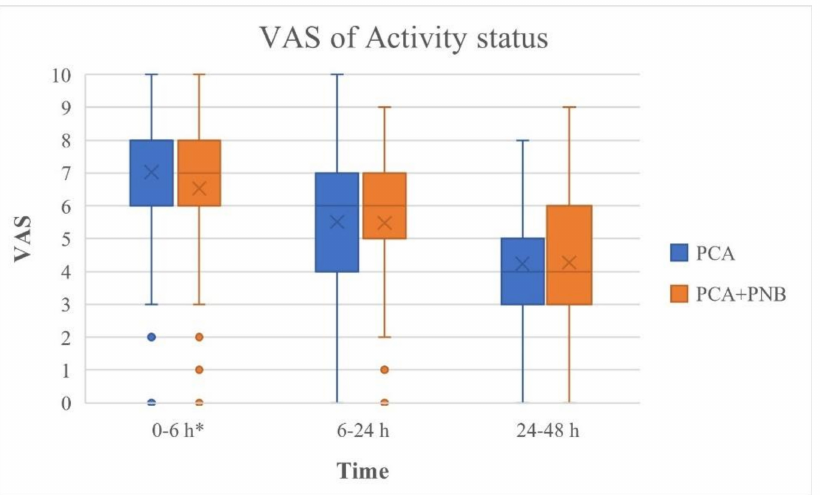
Figure 3. VAS during activity for patients from the PCA and PCA + PNB groups who underwent THA. * Statistically significant difference between two groups ( p < 0.05). PCA: patient-controlled analgesia; PNB: peripheral nerve block; THA: total hip arthroplasty; VAS: visual analogue